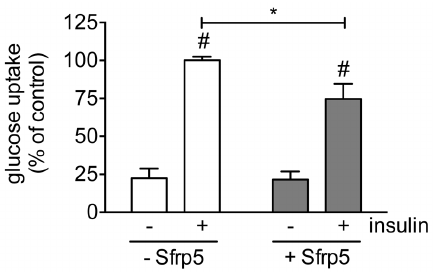
Figure 4. Effect of Sfrp5 on glucose uptake in primary human adipocytes. Mature adipocytes were kept untreated, exposed to 100 ng/ml Sfrp5 for 24 h, when indicated ( + ) stimulated with insulin (30 min; 100 nM), whereafter glucose uptake was determined. The incorporated amount of 2-deoxy-D-[1- 3 H]glucose was normalized for protein content and expressed as mean 6 standard error of the mean of four independent experiments using cells from different donors. The values obtained for Sfrp5-untreated, insulin-treated cells were consid- ered as control and set at 100%. Differences among groups were calculated by two-way ANOVA followed by Bonferroni multiple comparison analysis. # , indicates p , 0.05 for the effect of insulin stimulation; *, p , 0.05 for the effect of Sfrp5.